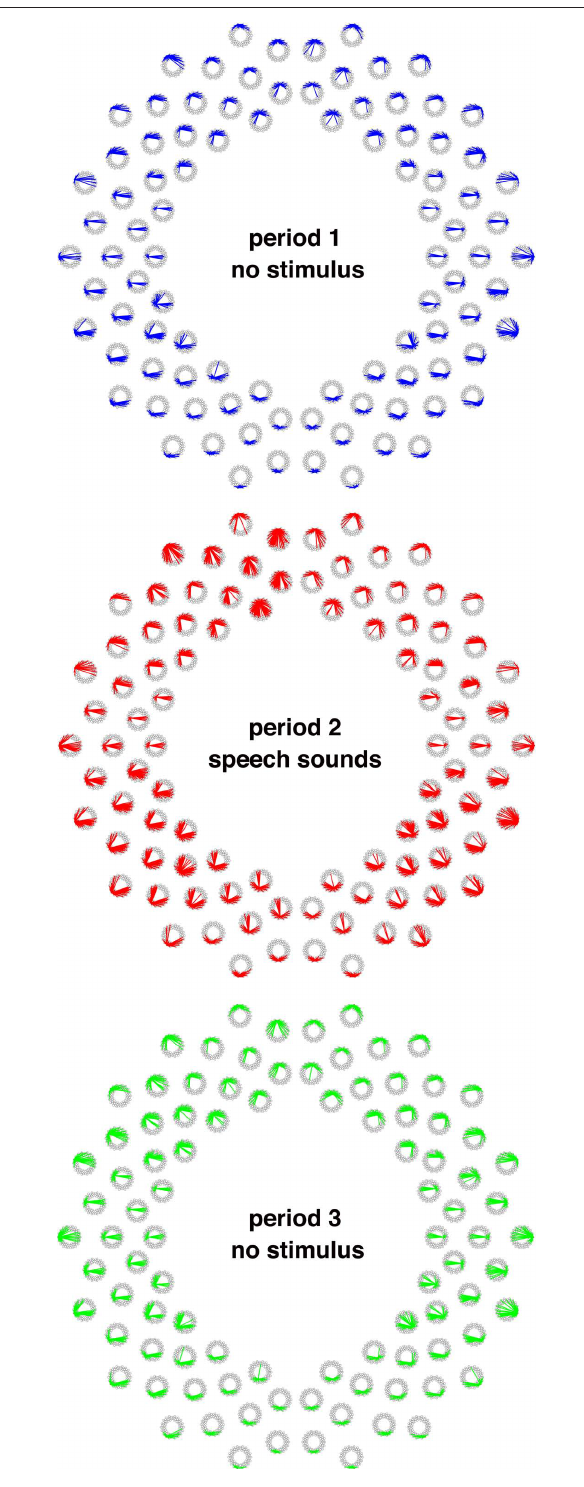
FIguRe 7 | All the connectivity in the three periods. The lines show correlations that were higher than 0.5 (averaged across all infants). The correlations between one of the 94 measurement channels and other channels are shown according to the arrangement of channel settings ( Figure 1B ).